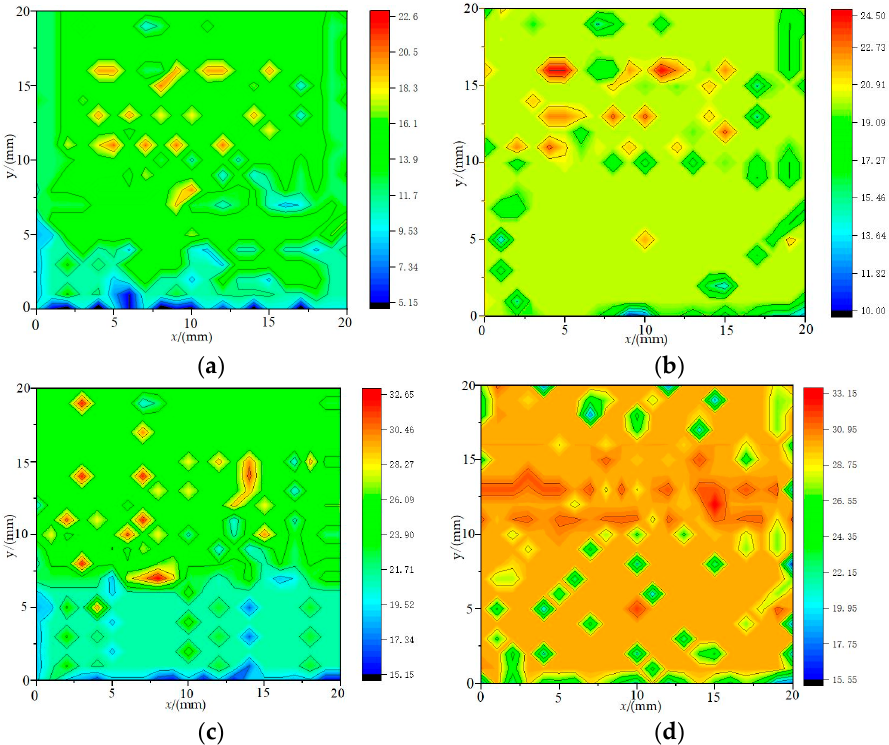
Figure 8. ( a ) Uniformity of coverage at F1T1 level; ( b ) Uniformity of coverage at F1T2 level; ( c ) Uniformity of coverage at F1T3 level; ( d ) Uniformity of coverage at F1T4 level. formity of coverage at F1T3 level; ( d ) Uniformity of coverage at F1T4